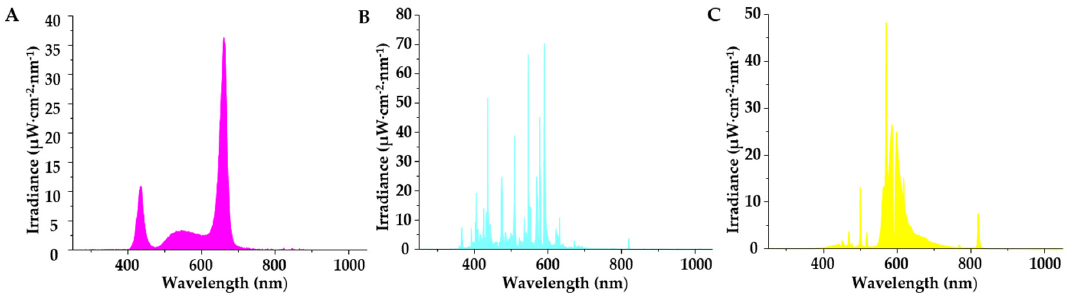
Figure 1. The spectral distribution of mixed (red: blue: white = 6:1:1) light-emitting diodes (LED-mix, ( A )), metal halide lamps (MH, ( B )), and high-pressure sodium lamps (HPS, ( C )).